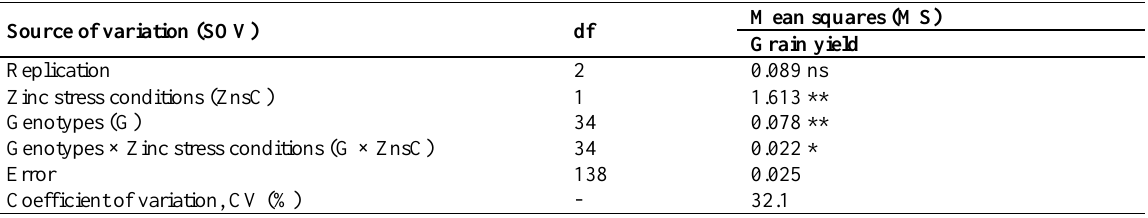
Table 3. Analysis of variance (ANOVA) for grain yield of 35 durum wheat genotypes under zinc deficit stress and non-stress conditions.